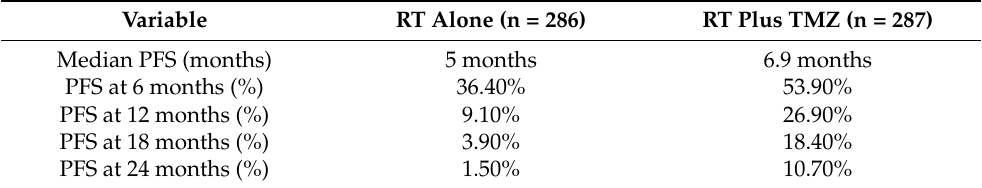
Table 3. Progression-free survival (PFS) of glioblastoma patients with radiation therapy alone compared to radiation therapy plus temozolomide [5].